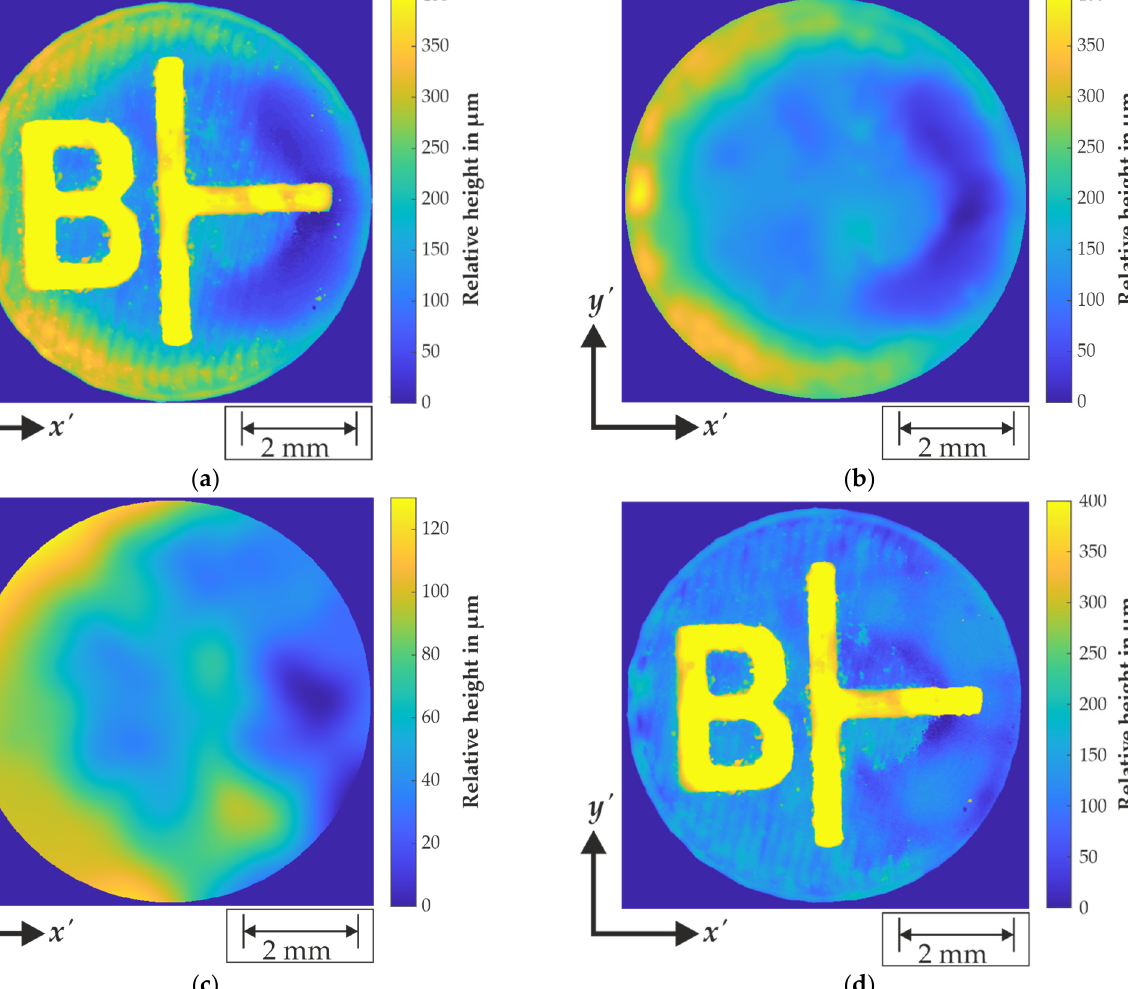
Figure 5. ( a ) Part surface extracted by thresholding algorithm. ( b ) Reconstructed part surface after removal of registration landmarks. ( c ) Reconstructed surface from lowest pores in the transition zone (between sections 5 and 6) at an approximately average specimen height of 10.7 mm. ( d ) Part surface after application of deformation adjustment function extracted by thresholding algorithm.